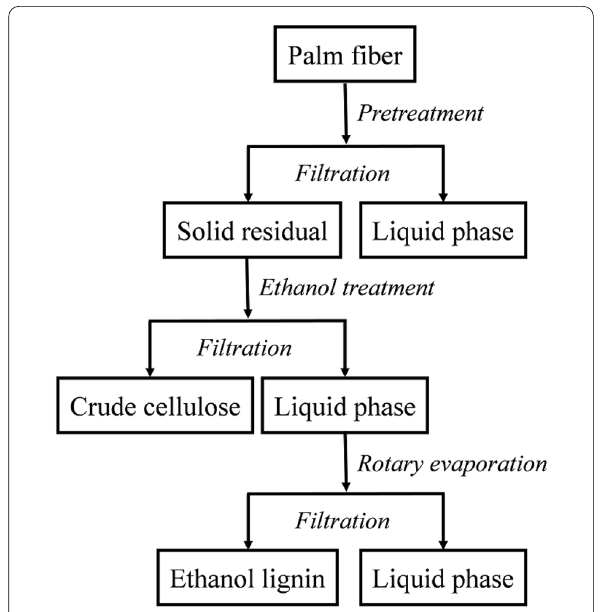
Fig. 1 Flow diagram of the separation of lignin from palm fibers via ethanol